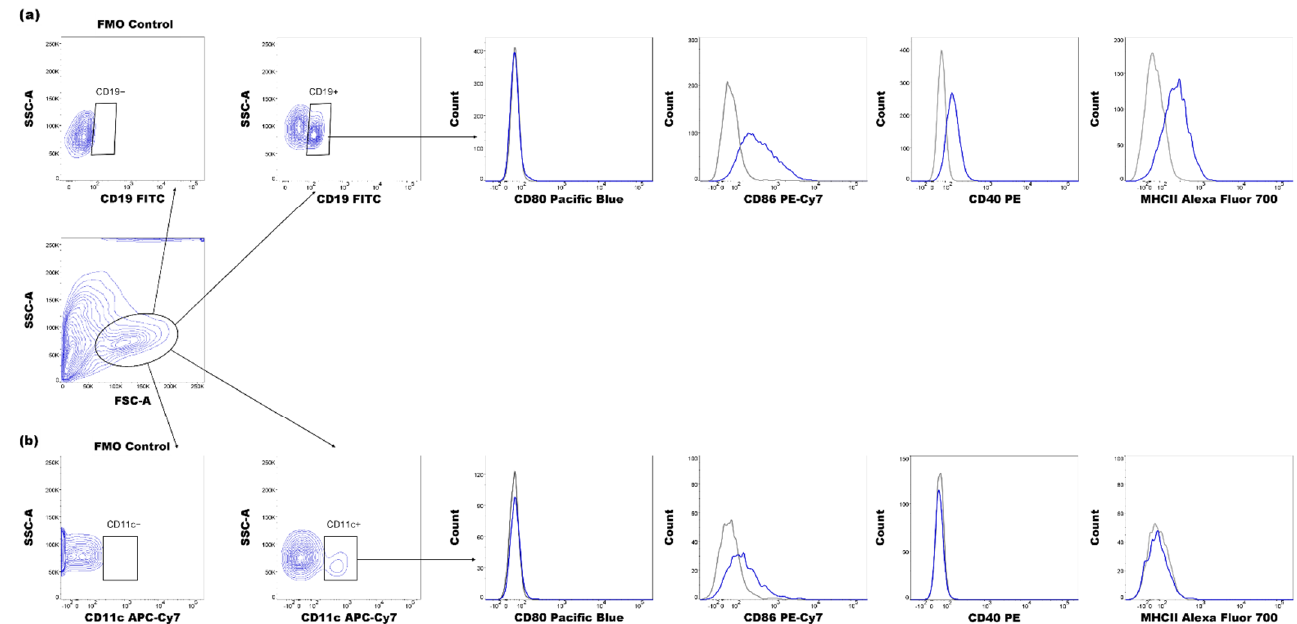
Figure 6. Representative histograms of the expression of CD40, CD80, CD86, and major histocompatibility class II molecules (blue histograms) overlayed with those in the respective isotype-matched controls (gray histograms) in ( a ) CD19 + cells and ( b ) CD11c + cells derived from the spleens of abortion-prone mice.